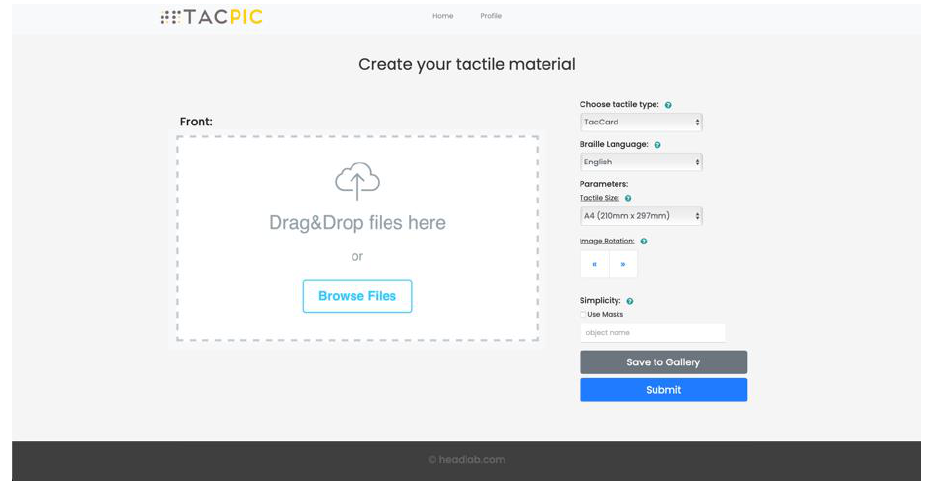
Figure 10. TacPic